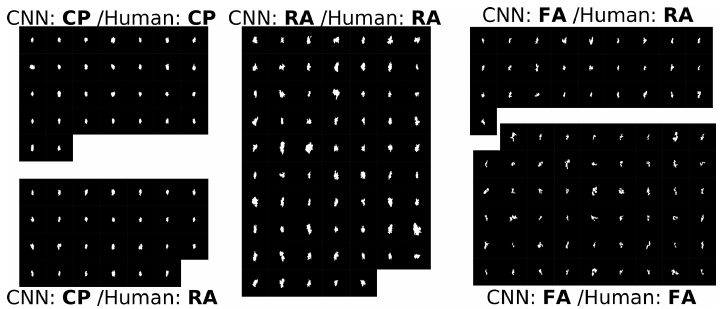
Figure A3. Confusion between humans (majority rule) and the CNN for the RA, FA, and CP classes. The CNN predictions are more consistent than those of humans.